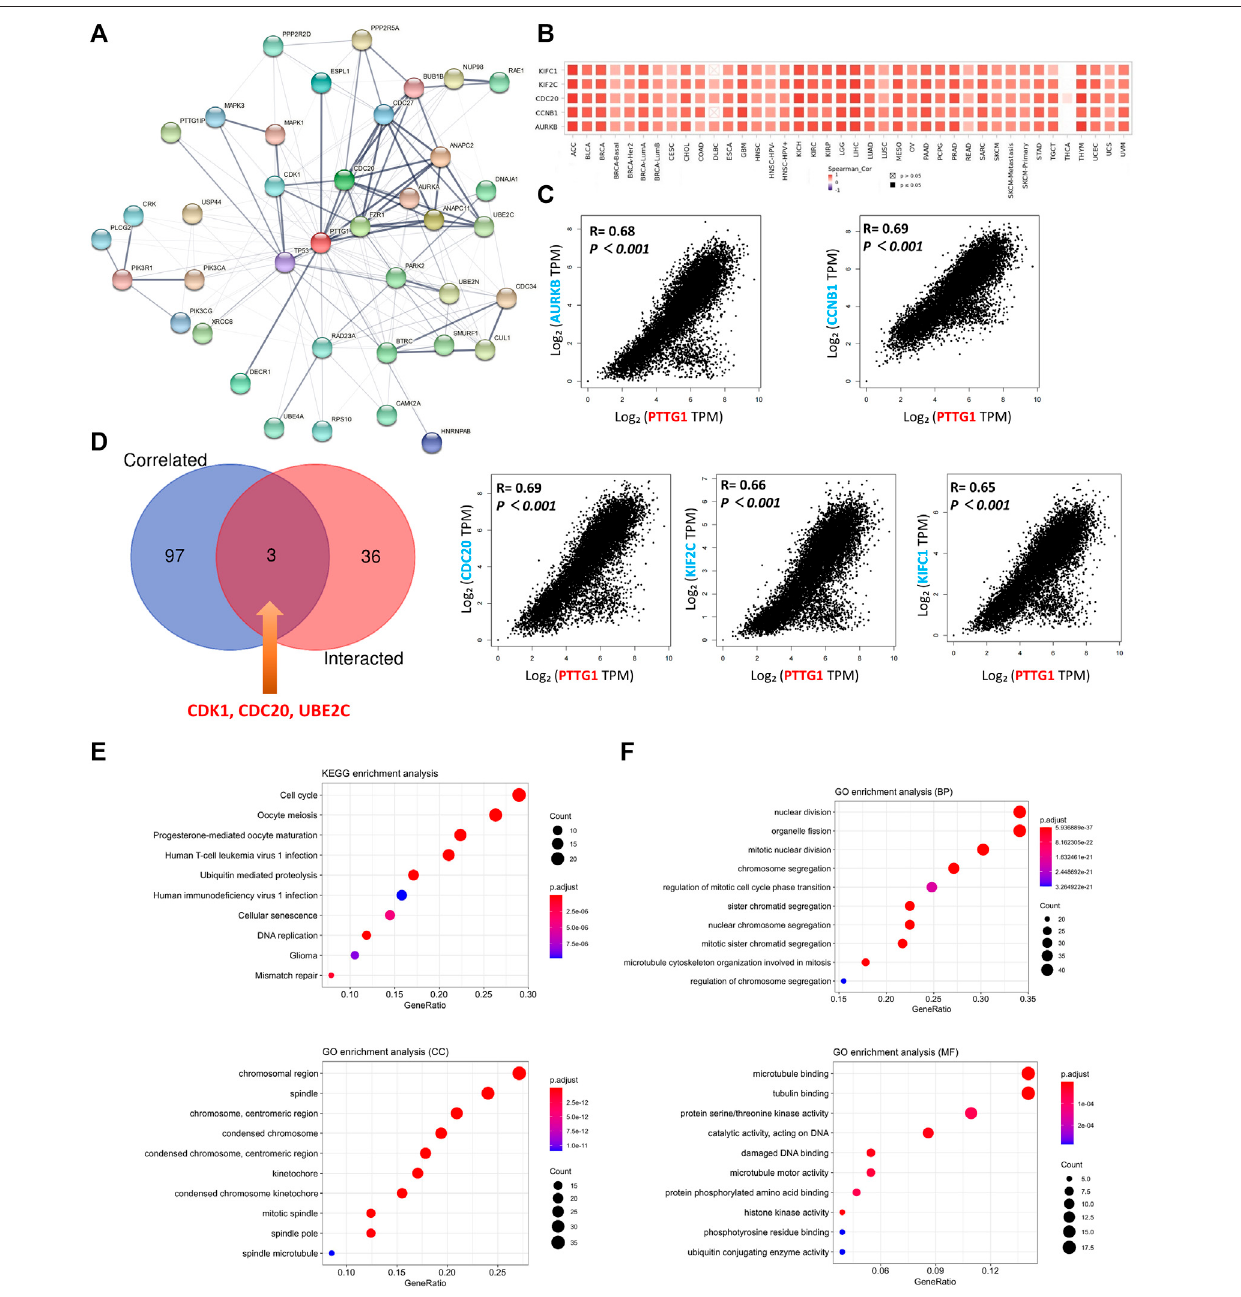
FIGURE 6 | The related gene analysis for PTTG1. (A) A protein-protein interaction (PPI) network of 39 PTTG1-interacted experimentally veri fi ed proteins were shown. (B) The top 100 genes which were linked to the PTTG1 expression were obtained, and the top fi ve genes was shown, named AURKB, CCNB1, CDC20, KIF2C and KIFC1. The heatmap data which displayed the correlation of the top fi ve genes with different tumors were shown. (C) The expression correlations between the top fi ve genes and PTTG1 were also displayed. (D) The intersection analysis of the PTTG1-correlated and PTTG1-interacted genes was conducted and three genes were obtained, namely CDK1, CDC20 and UBE2C. (E) KEGG pathway analysis was obtained according to PTTG1-correlated and interacted genes; (F) The GO enrichment in biological process (BP) terms, cellular component (CC) terms, and molecular function (MF) terms.